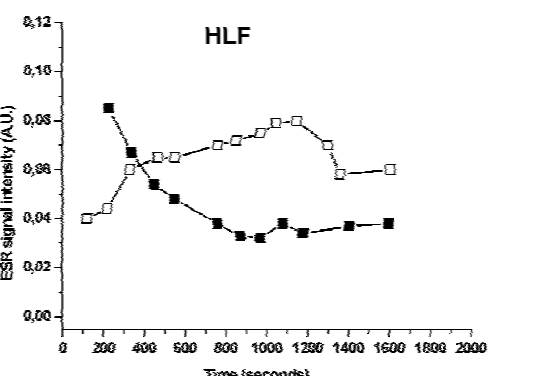
FIGURE 3. The time course of the ESR signal intensity in model Fenton reaction in the presence of L-41 and HLF cell crude extracts. ■ – 1 × 0.168 mg/ml of protein in the ESR sample; □ – 2 × 0.168 mg/ml of protein in the ESR sample. The